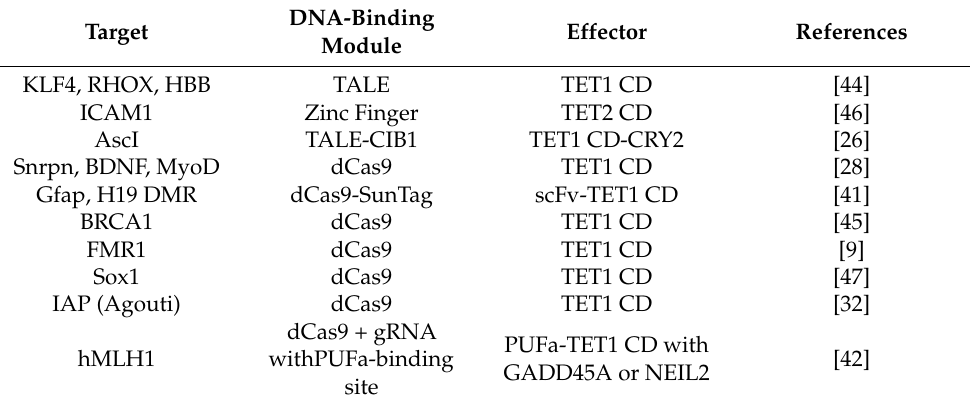
Table 2. Editing DNA methylation with ten-eleven translocation (TET)